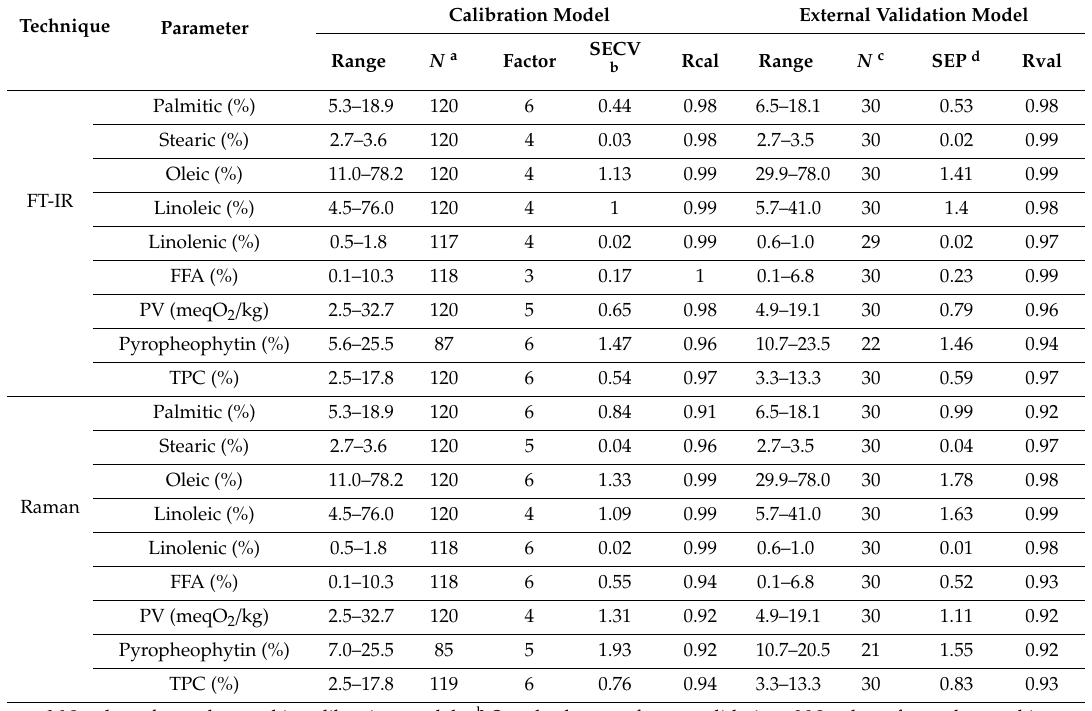
Table 5. Performance statistics of calibration and external validation models developed by using portable FT-IR and compact benchtop Raman